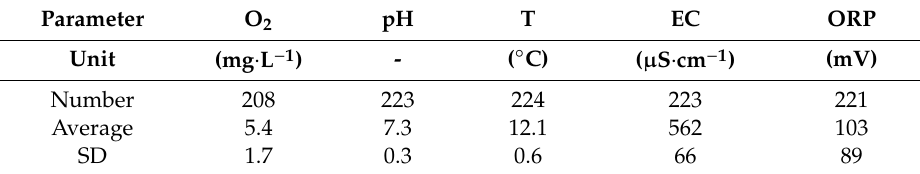
Table 1. Baseline of the chemico-physical parameters.